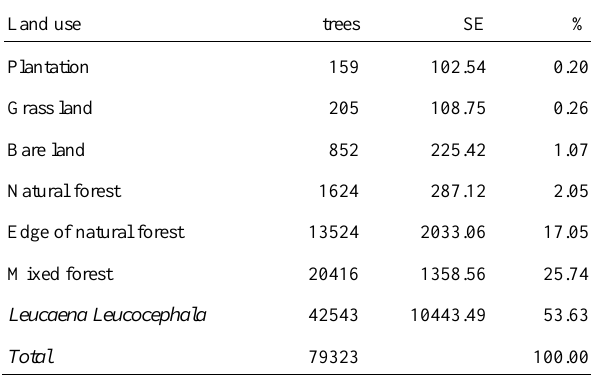
Table 1. The number of Leucaena Leucocephala invasion in different landuse